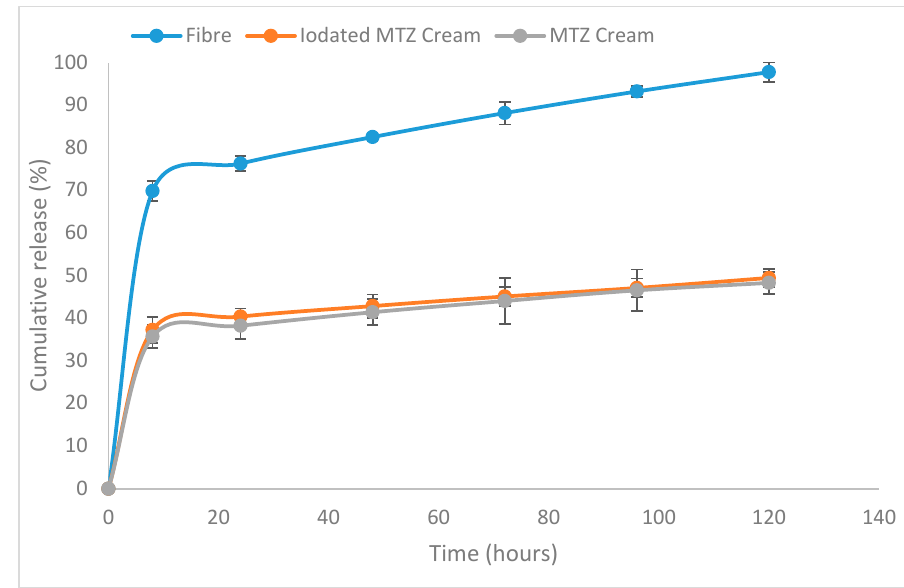
Figure 6. Cumulative percentage of drug (MTZ and iodated MTZ) released from the trilayered fiber systems and cream formulations obtained during the study over a five-day period.